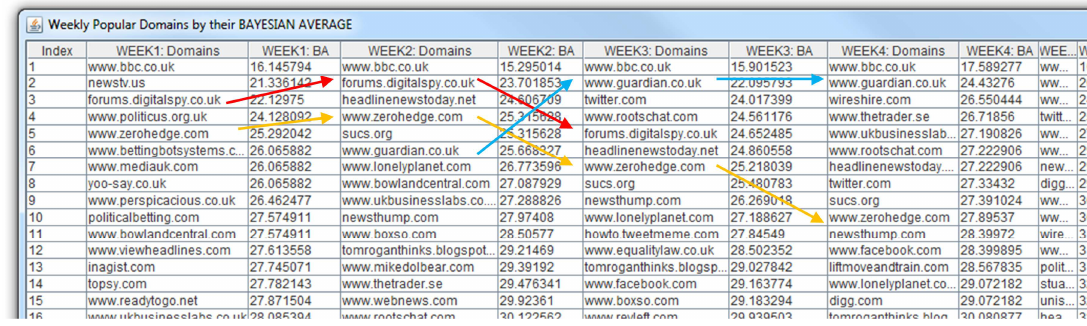
Figure 6: Search Results - Bayesian Average Rankings per